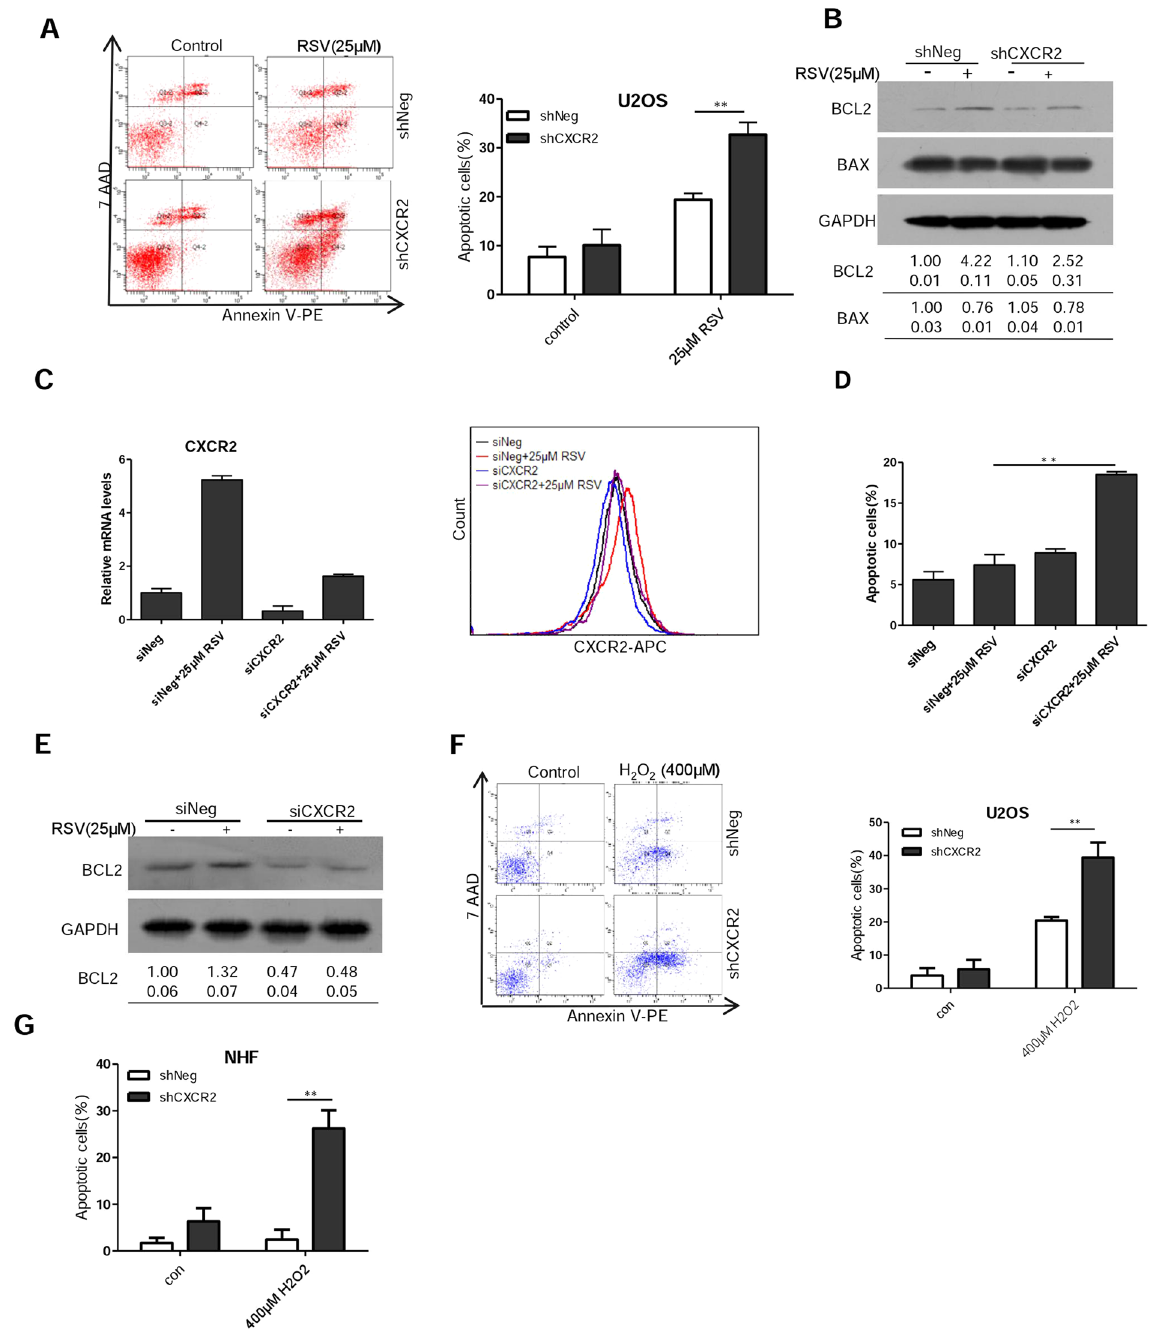
Figure 6. CXCR2 protects cells from undergoing stress-induced apoptosis. ( A ) Apoptosis in shNeg and shCXCR2 U2OS cells was measured 3 days after treatment with RSV (25 μ M) by flow cytometry. ( B ) Cells were treated as in ( A ) and whole-cell extracts were collected for Western blot analysis using BCL2 and BAX antibodies. ( C ) Downregulation of CXCR2 by siRNA as measured by RT-PCR and flow cytometry. U2OS cells were transfected with siRNA duplexes (200 nmol/L) specific to CXCR2 or scrabbled oligo in serum-free medium for 6 hours, then were incubated with complete medium for 24 h and then incubated with RSV for 3 days. ( D ) U2OS cells were treated the same as in ( C ) and apoptosis was measured by flow cytometry. ( E ) The U2OS cells were treated the same as in ( C ) and whole-cell extracts were collected for Western blot analysis using BCL2 antibodies. ( F ) Apoptosis in shNeg and shCXCR2 U2OS cells was measured by flow cytometry 2 days after treatment with H 2 O 2 (400 μ M). Results shown are representative of three independent experiments. ( G ) The shNeg and shCXCR2 NHF cells were treated the same as in ( F ) and apoptosis was measured by flow cytometry. The numbers shown below Western blot images are means (first row) and SE (second row) of band intensities relative to control. Signals on the immunoblots were analyzed by ImageJ, normalized with that of